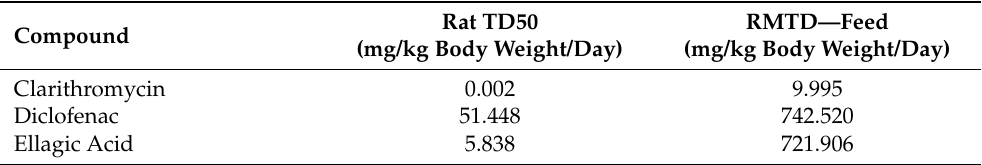
Table 7. Carcinogenic potential via TOPKAT (Rat TD50 and RMTD).